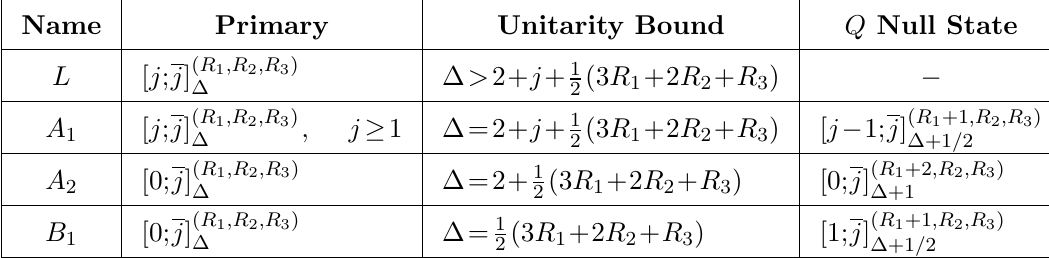
Table 19 . Q shortening conditions in four-dimensional N = 4 SCFTs.